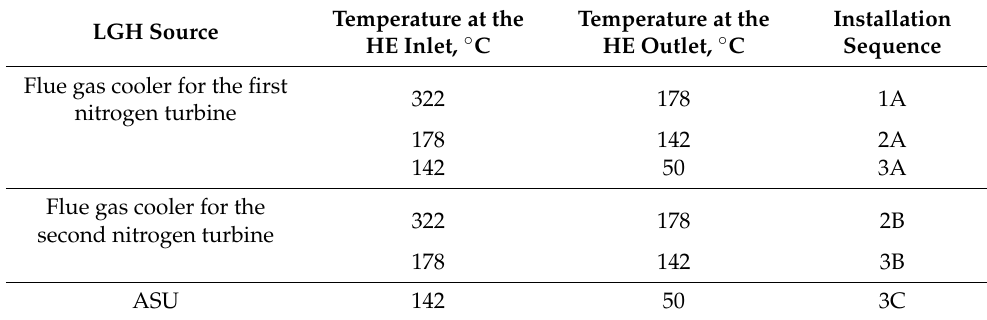
Table 4. Characteristics of low-potential heat sources of OFPP. Table 4. Input data for low-potential heat sources of OFPP. LGH Source LGH Source